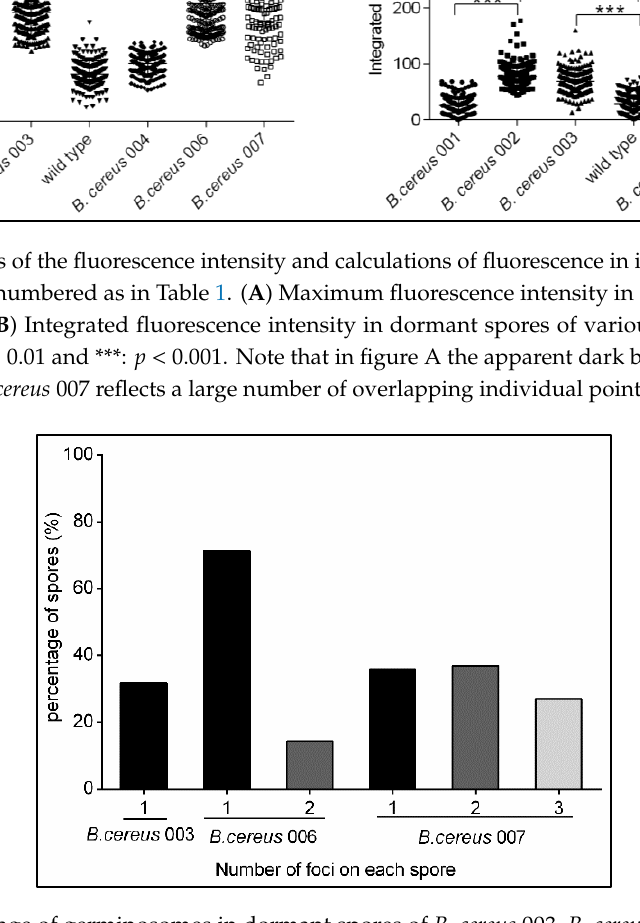
Figure 5. Construction of B. cereus 007 and visualization of GerD-mScarlet-I in dormant spores. ( A ), schematic diagram of plasmid pHT315-PgerD-gerD-mScarlet-I. phase-contrast ( B , D ) and fluorescence microscopy images ( C , E ) of B. cereus dormant spores: ( B , C ) wild-type spores and (D, E ) spores carrying pHT315-PgerD-gerD-mScarlet-I. The white arrows indicate GerD in germinosomes. All panels are at the same magnification, and the scale bar is 5 μm. 2.2. Validation that All Spores Carry Plasmids One concern in using a plasmid-encoded fusion protein gene to visualize potential germinosomes in spores, is that plasmid partition at the sporulation division may or may not be 100% [32–34]. Consequently, many spores from plasmid-carrying cells may not carry the gene for the fusion protein. To examine this possibility, 24 colonies, each generated by single spores obtained from B. cereus cells carrying pHT315-P gerR - gerRB - SGFP2 , were examined on TSB-agar plates containing 10